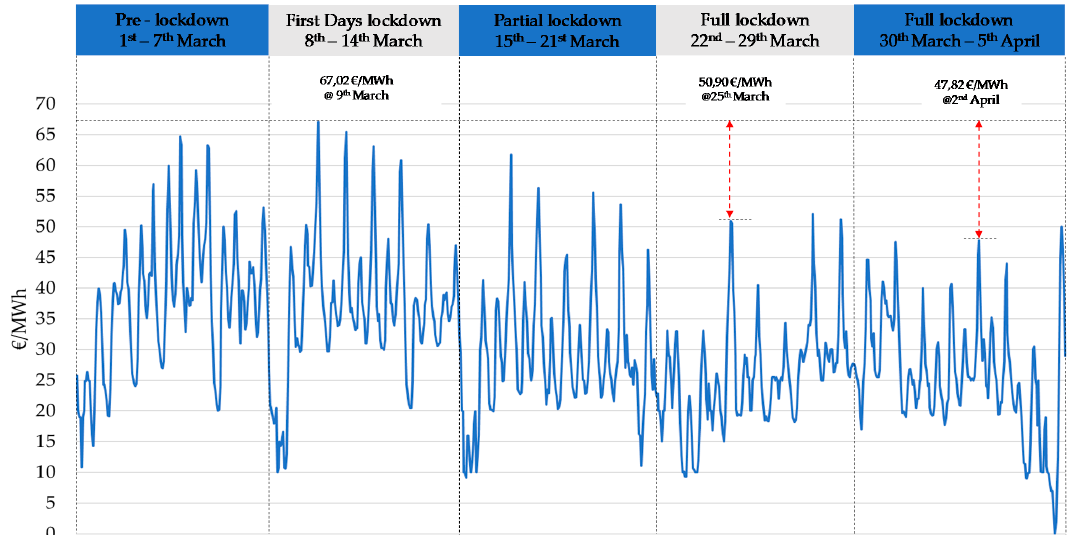
Figure 15. National single price (PUN) on IPEX. Dates 1st March–5th April 2020.